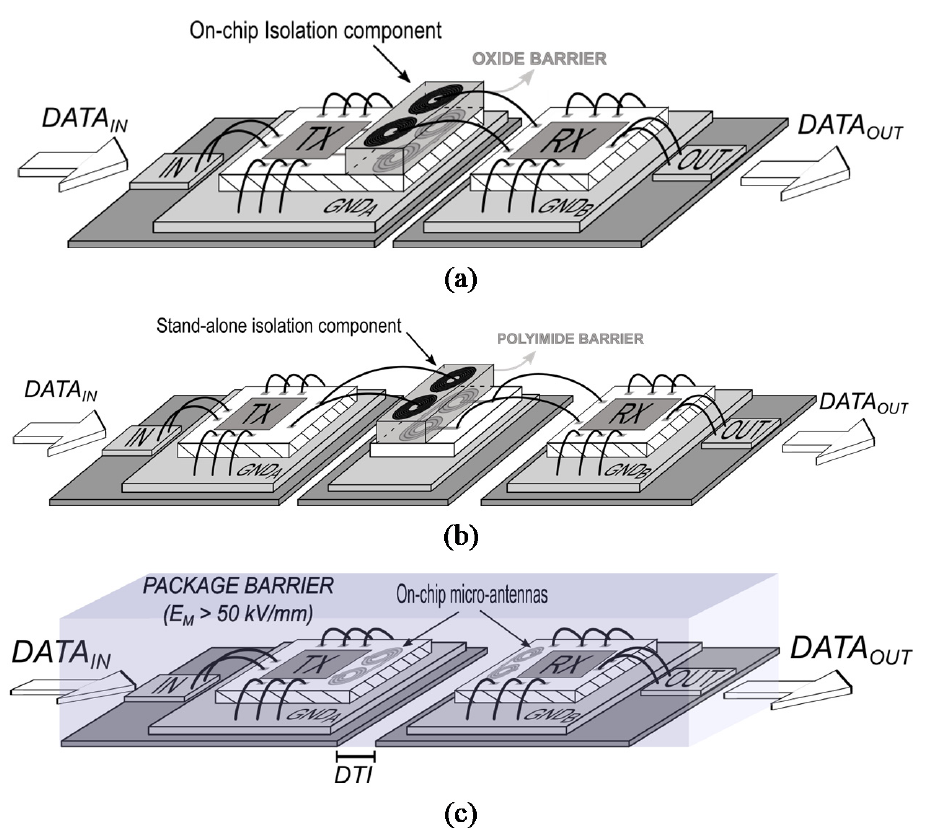
Figure 2. Chip-scale versus package-scale isolation: integrated barrier ( a ); stand-alone post-processed barrier ( b ); package-scale barrier ( c